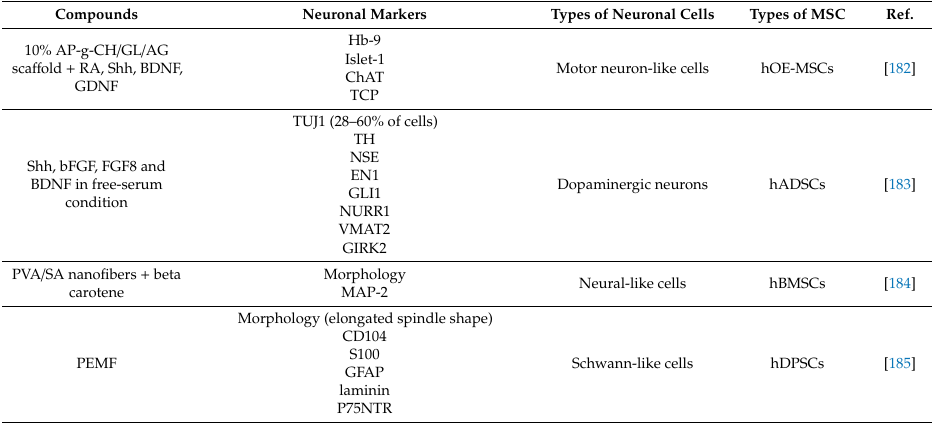
Table 1. Neurogenic di ff erentiation